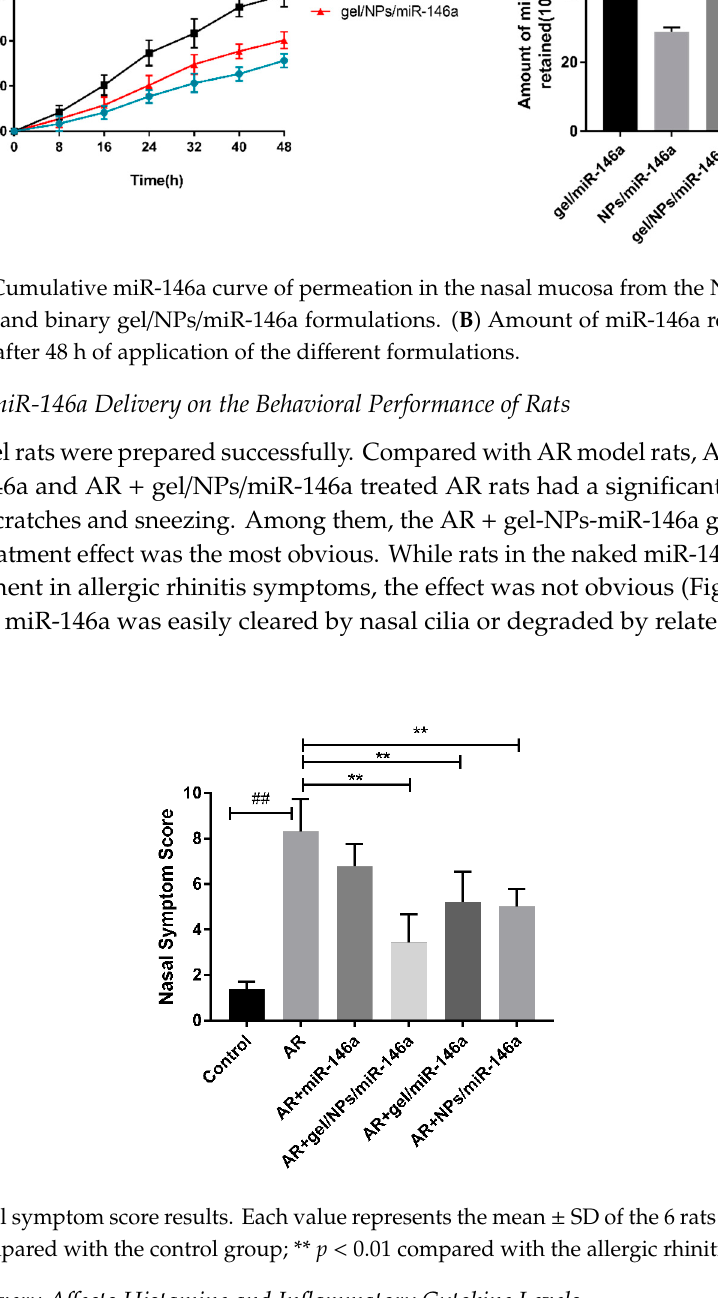
8 of 17 Table 3. Evaluation parameters for miR-146a in chitosan gel. Formulation ( C ) Figure 2. Gel properties. ( A ) Gelation gel strength, ( B ) mucosal adhesion strength and ( C ) mucosal adhesion duration of various thermosensitive mucoadhesive gel preparations (for gel composition, please refer to Table 2). The data represent the mean ± SD ( n = 4). 3.4. Ex Vivo Nasal Mucosal Penetration and Retentionabsorption Efficiency of miR146a The penetration rates of miR-146 from NPs/miR-146a and gel/miR-146a were 61% and 31%, respectively, and the penetration rate of the gel/NPs/miR-146a binary formulation was 40% (Figure 3A). The results showed that the use of delivery vehicles significantly hindered the penetration of miRNA from the mucosa, and the hydrogel formulation had a stronger hindering effect. In order to evaluate the effective dose that actually remained in the inflamed mucosa after the topical application of different formulations in the nose, miRNA was recovered from the mucosa 48 h after administration and delivery. The gel/NPs/miR-146a binary formulation showed the highest mucosal retention rate, with 51% of the initial dose remaining in the mucosa. After 48 h, the mucosal retention